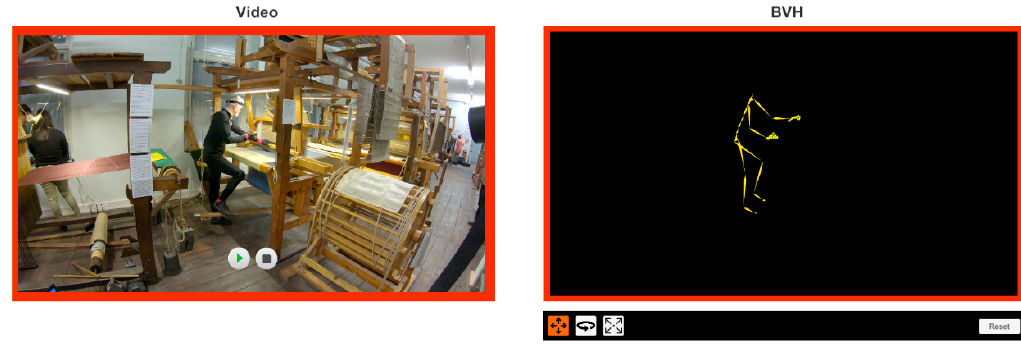
Figure 3. Video and 3D motion windows.